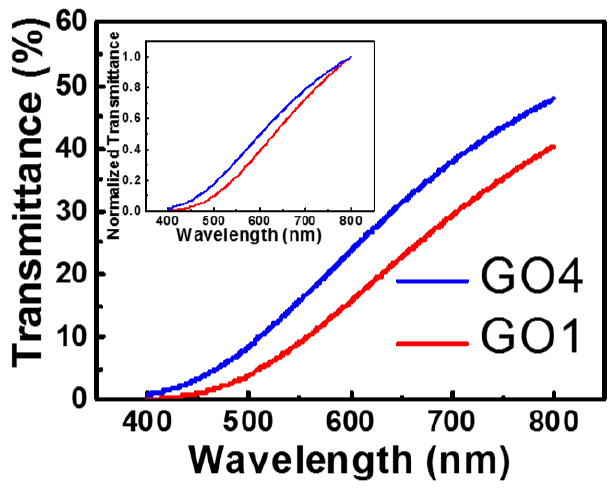
Figure 2. Transmittance of GO aqueous solutions with different oxidation degrees. The inset presents the normalized curves. The onset for GO4 is shifted to shorter wavelengths than those for